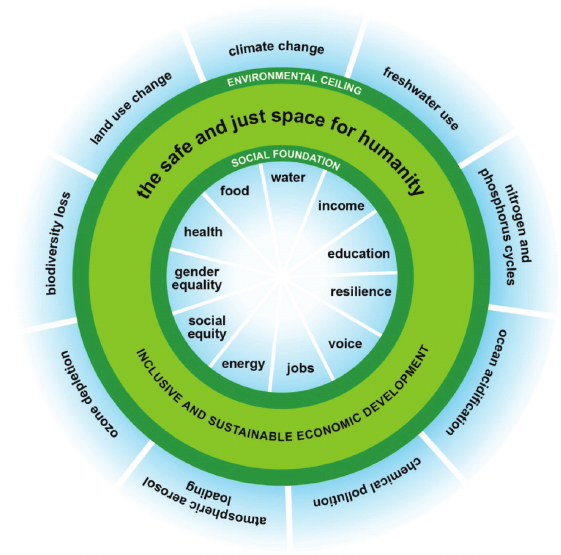
Figure 1 - The nine dimensions of the environmental ceiling are based on the planetary boundaries. Source: Raworth